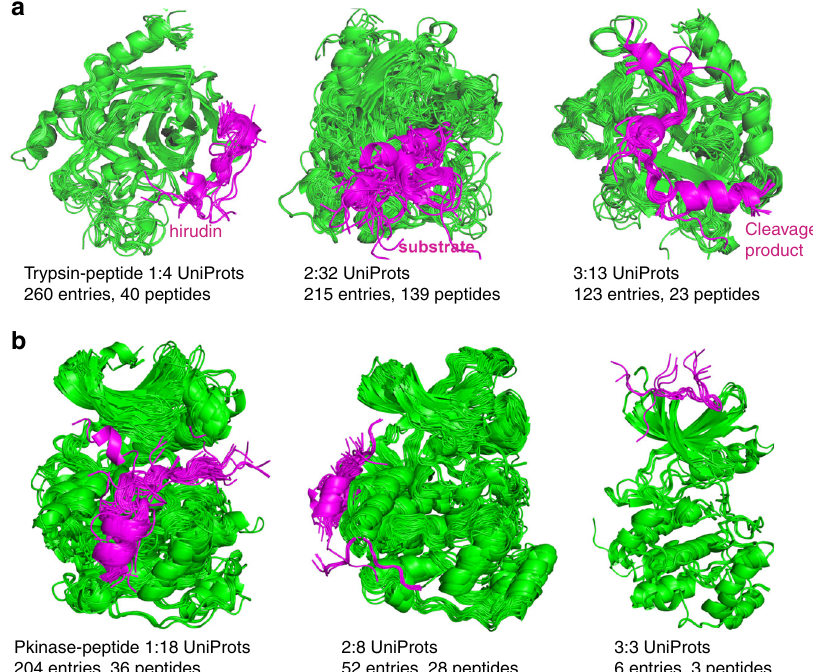
Fig. 4 Pfam-peptide interactions. a Three trypsin-peptide interface clusters. The number of peptides indicates the number of unique peptide sequences; the peptide sequences of each cluster can be found on each cluster page on ProtCID. The Pfam domains are colored in green and the peptides are colored in magenta. The fi rst cluster mostly constists of human thrombin bound to peptides from hirudin from leeches. The peptides of the second cluster is a large set of substrates bound to the active sites of trypsin-like proteases. The peptides of the third cluster are cleavage products, created by internal cleavage by activating enzymes. b Pkinase – peptide interactions show the binding sites of substrates, activators, and inhibitors. Cluster 1 shows the peptides binding to active sites as inhibitors or substrates. Cluster 2 contains peptides binding to a groove between α d and α e and the β 7 – β 8 reverse turn on the kinase C-terminal domain. Cluster 3 is a small cluster of peptides binding to the N-terminal